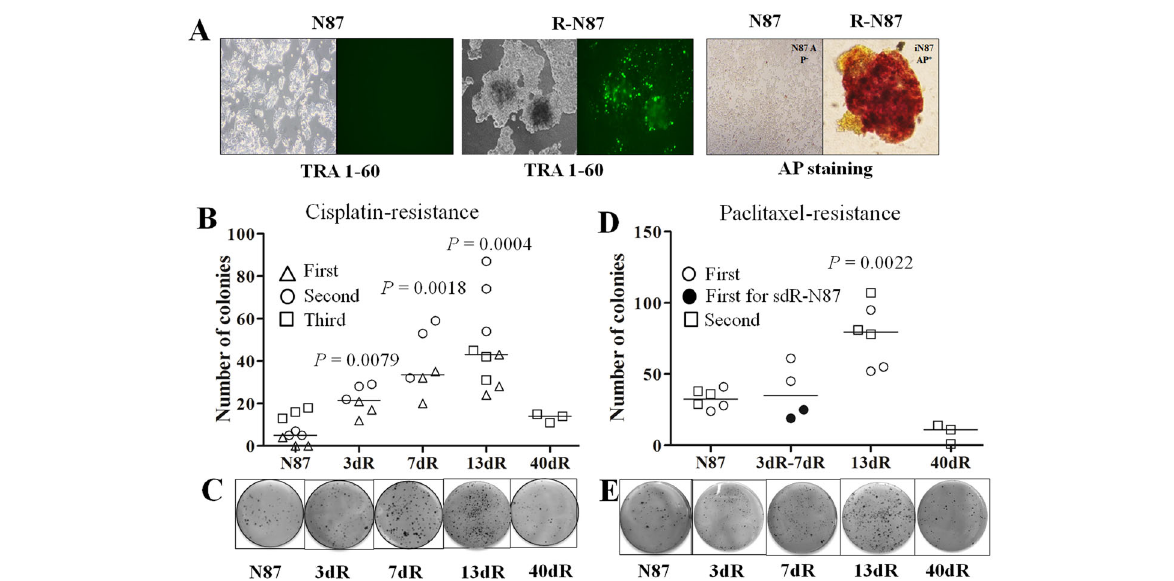
Fig. 3 Establishment of reprogrammed N87 (R-N87) cells. a TRA-1-60 and alkaline phosphatase staining in R-N87 cells after the transfection of mRNAs for reprogramming factors. Positivity for both TRA-1-60 and alkaline phosphatase was observed in the established R-N87 (R-N87) cells but not in parental N87 (N87) cells. b Colony-formation assay after treatment with cisplatin (5 μ M) in R-87 cells. The 13dR-N87 cells also showed signi fi cantly greater numbers of colonies than the 3dR-N87 cells ( P = 0.0067). The experiment was repeated three times ( fi rst, second, and third), and the